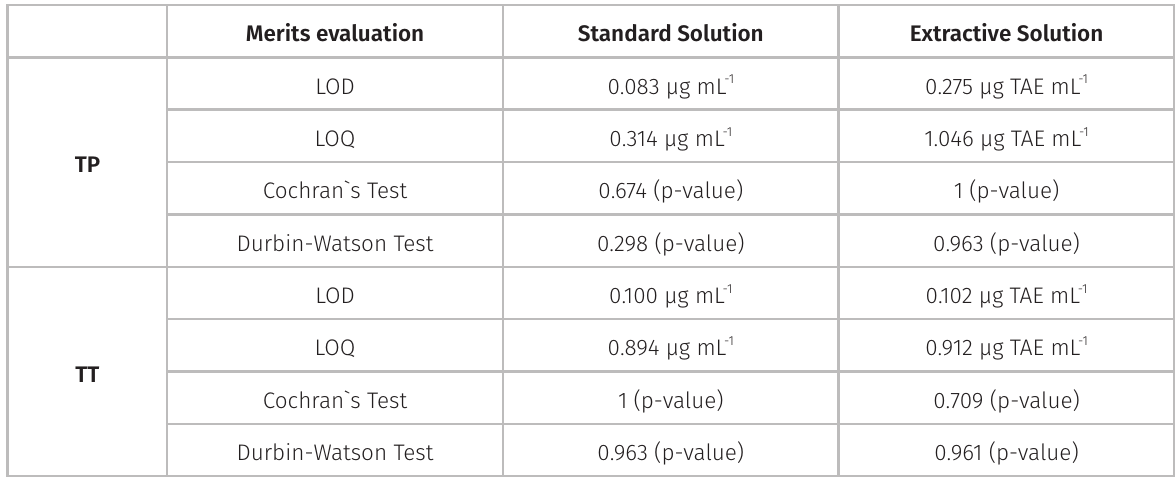
Table III. Robustness results.